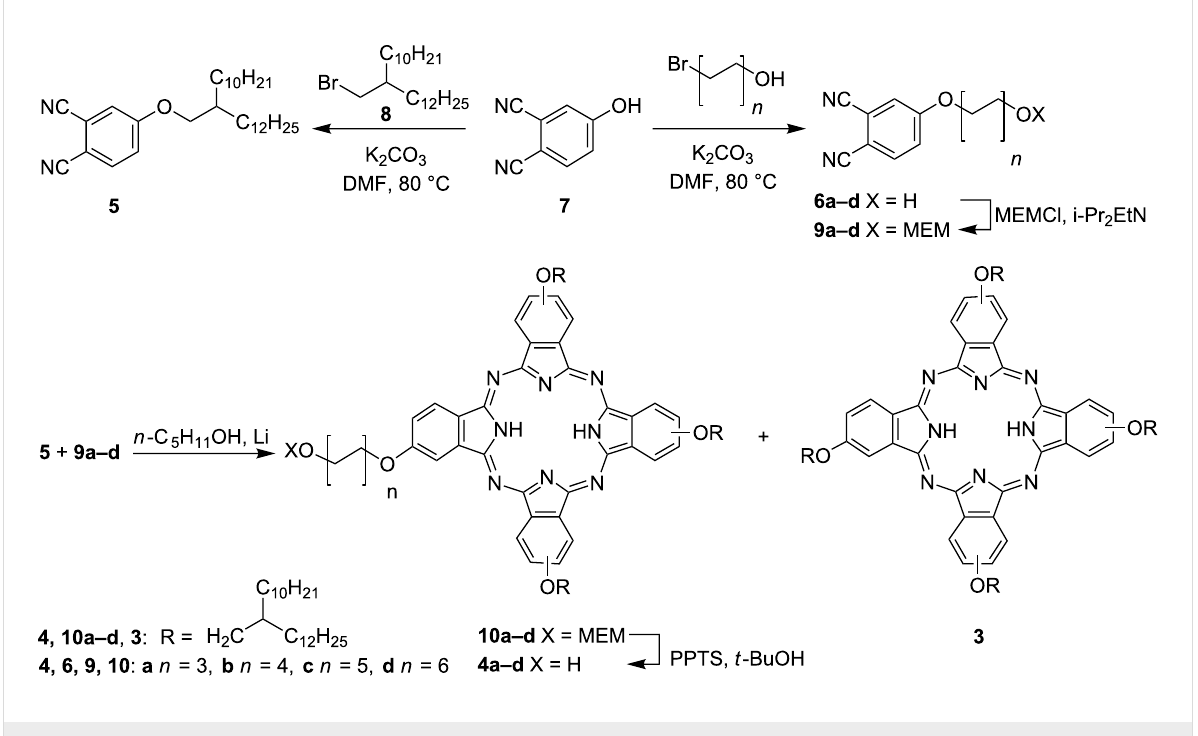
Scheme 1: Synthesis of low-symmetry phthalocyanines 4a–d